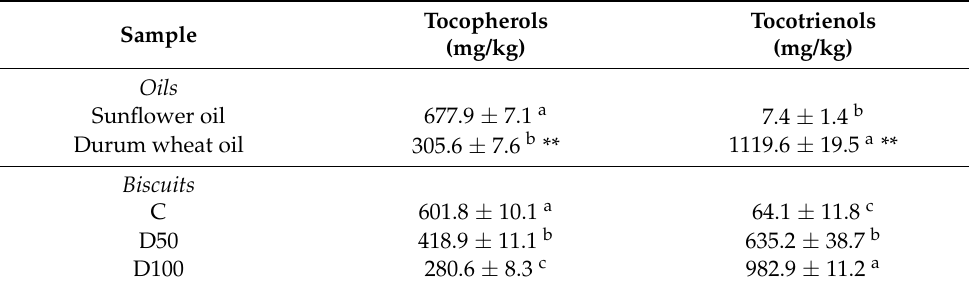
Table 3. Total tocopherols and tocotrienols of the oils and biscuits. C = Biscuits prepared with 100% sunflower oil; D50 = biscuits prepared with sunflower oil (50%) and durum wheat oil (50%); D100 = biscuits prepared with 100% durum wheat oil.